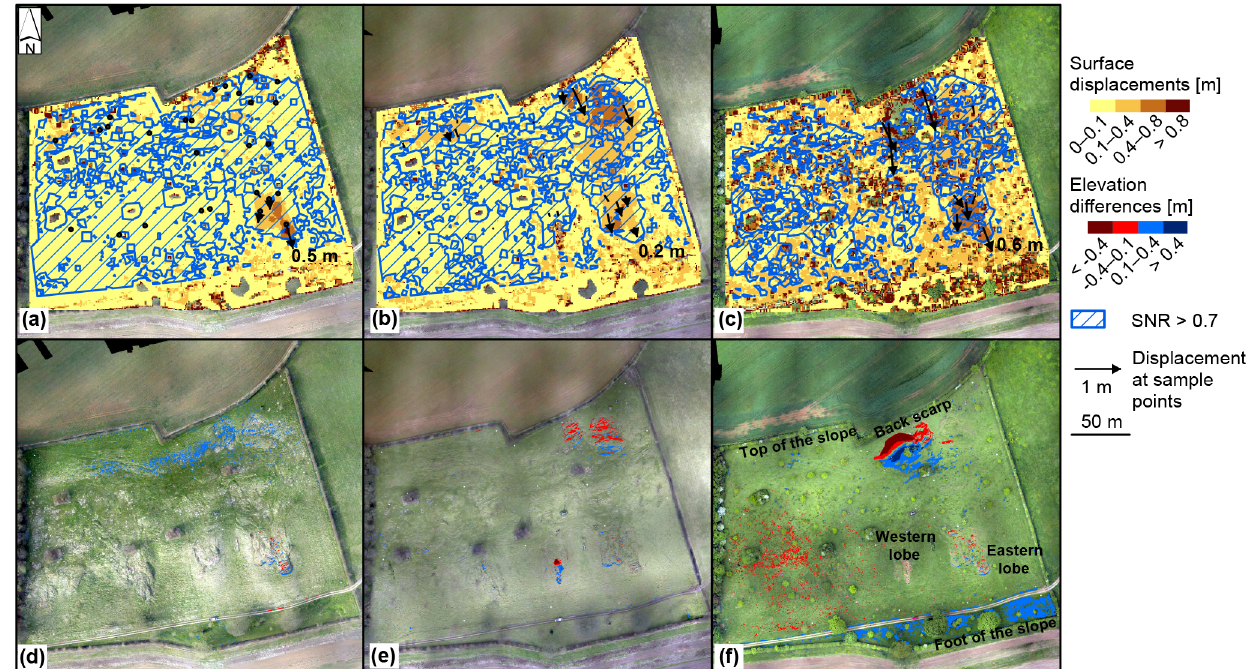
Figure 3. Maps of surface displacements and elevation differences of ( a and d ) December 2014–March 2015, ( b and e ) March 2015– February 2016 and ( c and f ) February–May 2016 respectively. Manually derived planimetric vectors at sample points are also superimposed (Peppa et al.,